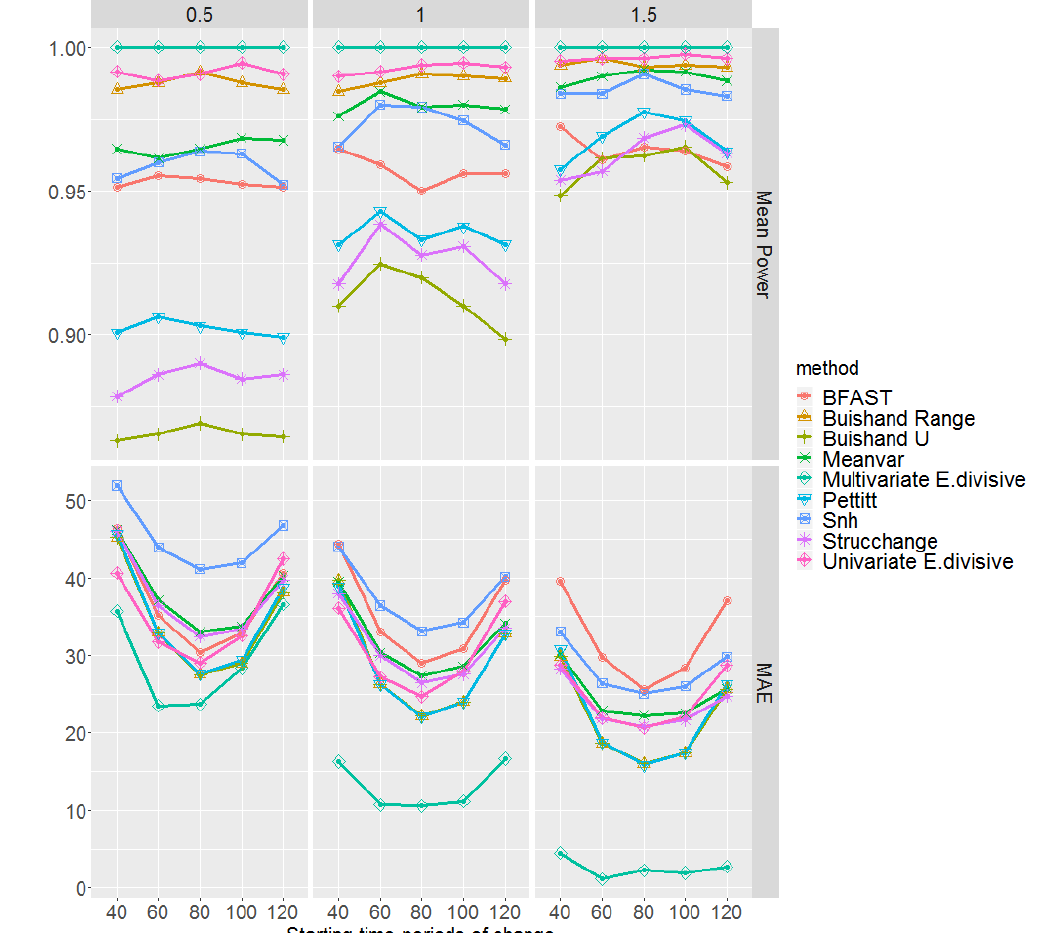
Figure 7. Mean empirical power of the tests and mean absolute error (MAE) of the change-point detection methods with respect to the magnitudes of change 0.5,1,1.5 and starting time-periods of change 40,60, . . . ,120. These are based on 100 simulations of multi-layer rasters under the second scenario, where pixel time series are generated from an autoregressive model with parameter